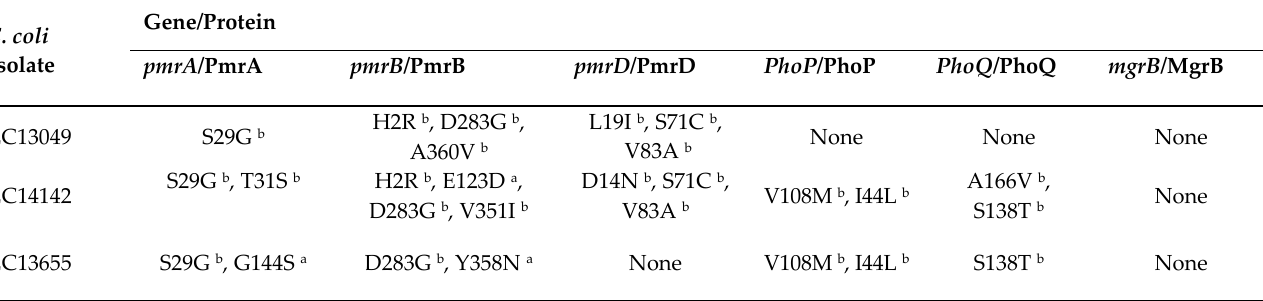
Table 3: Mutations in chromosomally encoded genes related to colistin resistance in tested E. coli clinical isolates.